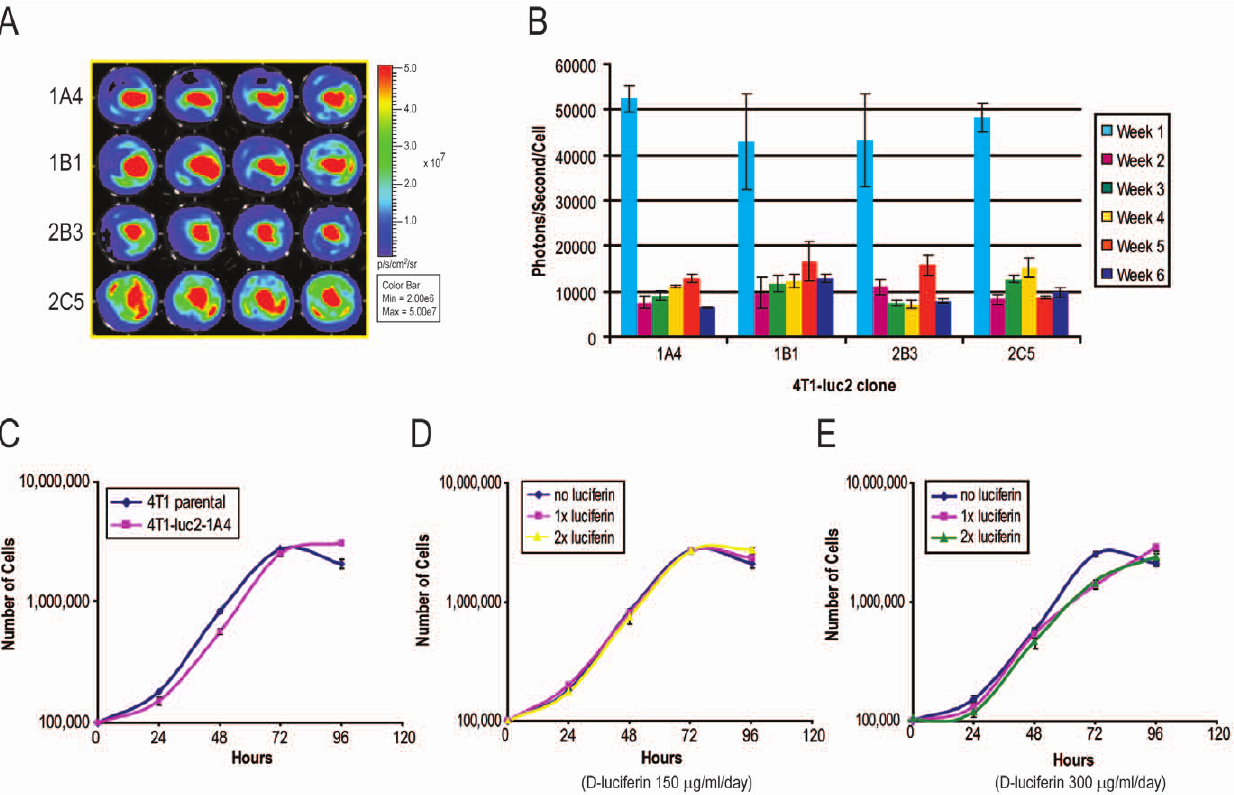
Figure 1. Generation of 4T1-luc2-1A4 cells and their growth patterns in the presence or absence of D-luciferin. (A) Generation of 4T1- luc2-1A4 cells. Mouse mammary tumor 4T1 cells were transfected with a lentiviral vector containing enhanced luciferase 2 under control of the human ubiquitin C promoter[16,18]. Puromycin-resistant clones were isolated and their luciferase expressions were screened by bioluminescence. Two rounds of cloning generated 4 single cell clones of 4T1-luc2. Luciferase activities were measured using an IVIS Spectrum (Binning: med, f stop: 1, exposure time: 1 sec). A typical bioluminescence image for testing stability of luciferase expression is shown. Total flux (photons/sec) was quantified using Living Image software 3.0. Clone 4T1-luc2-1A4 was selected and used for further studies. (B) Stability of luciferase activity of four 4T1-luc2 clones. Cells were grown for 6 weeks in regular media without puromycin and their light emission was monitored weekly. All clones showed more than 7,000 photons/sec/cell of light emission throughout the test period. (C) Growth curves of the 4T1-luc2-1A4 clone and parental 4T1 cells. Cells were grown for 4 days in regular growth medium without puromycin. Total numbers of cells over time were plotted in a logarithmic scale. Both cell lines showed similar growth patterns and doubling times. (D,E) Growth of the 4T1-luc2-1A4 clone and parental 4T1 cells in the presence of D-luciferin. Cells were fed with D-luciferin once a day (150 m g/ml/day, D) or twice a day (300 m g/ml/day, E), respectively, harvested at each time point and counted. Presence of the excess of D-luciferin did not affect the overall growth patterns of the 4T1-luc2